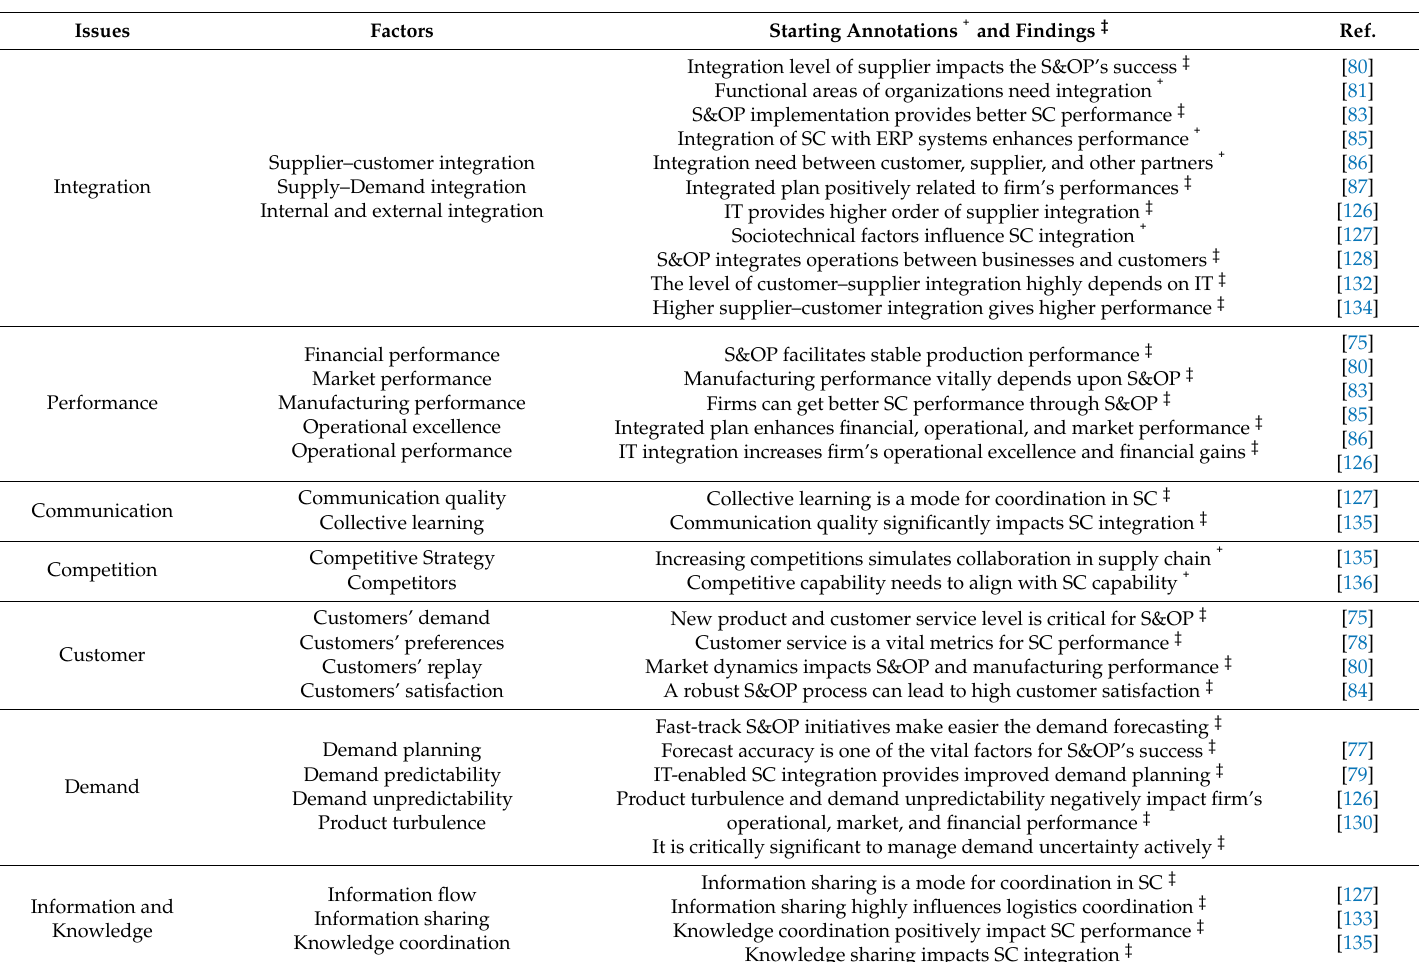
Table 4. Major annotations and findings of researchers on S&OP and SC